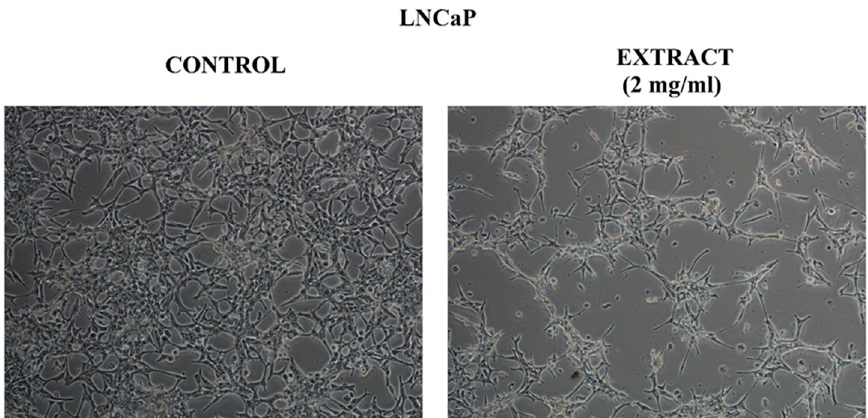
Figure 5. LNCaP cell morphology treated with CA extract or DMSO as a vehicle in control cultures for 48 h. They were analyzed using a phase-contrast microscope, Nikon Eclipse Ti. (Magnification × 100).